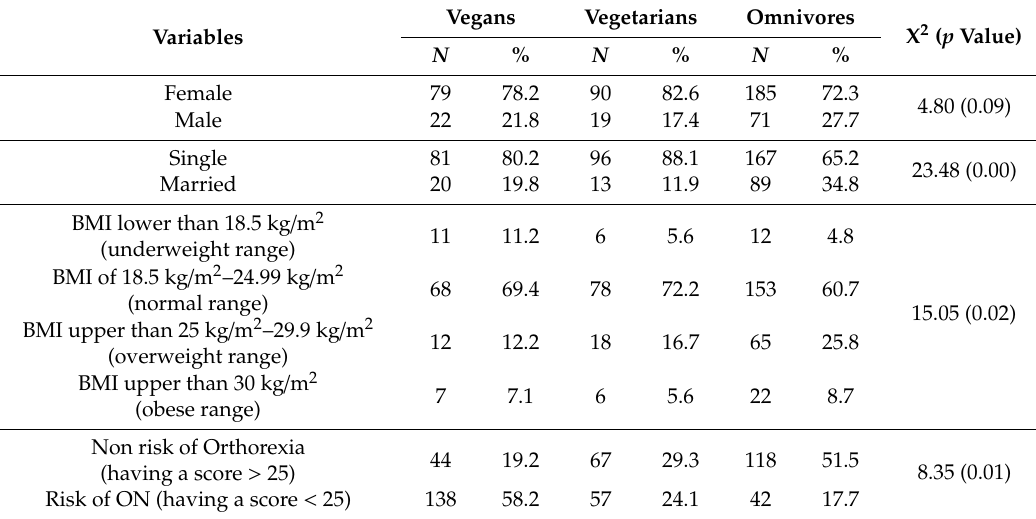
Table 1. Sociodemographic characteristics of the sample and relationships with type of diet by the Chi-squared test.